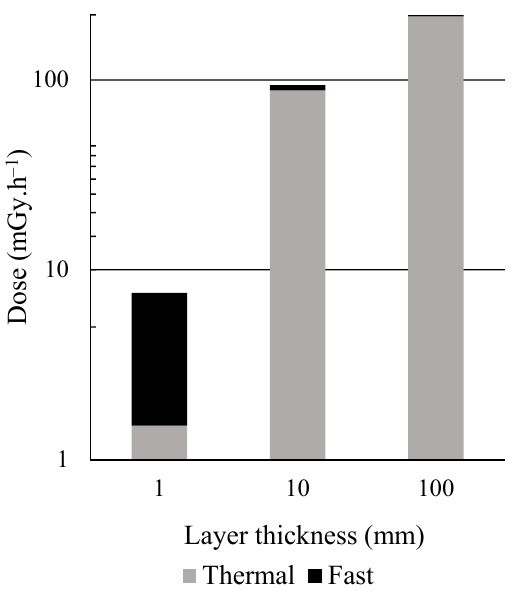
Figure 2. Dose induced by neutrons of different energy groups inside water layers of different thicknesses.